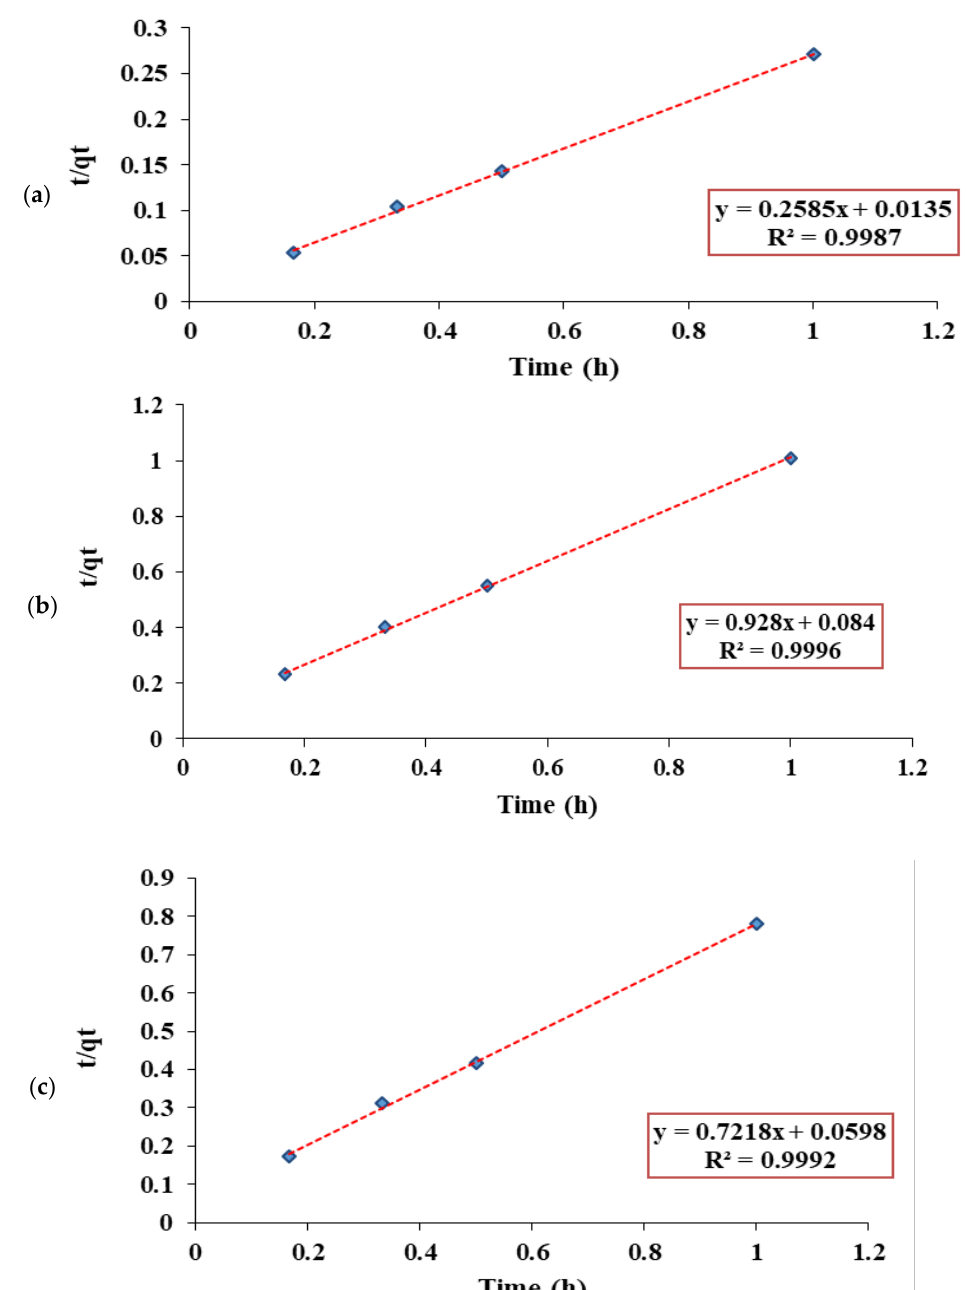
Figure 19. Linear plot of a pseudo-second-order kinetic model for the adsorption of calcium ions by ( a ) zeolite, ( b ) activated carbon, and ( c ) activated alumina.